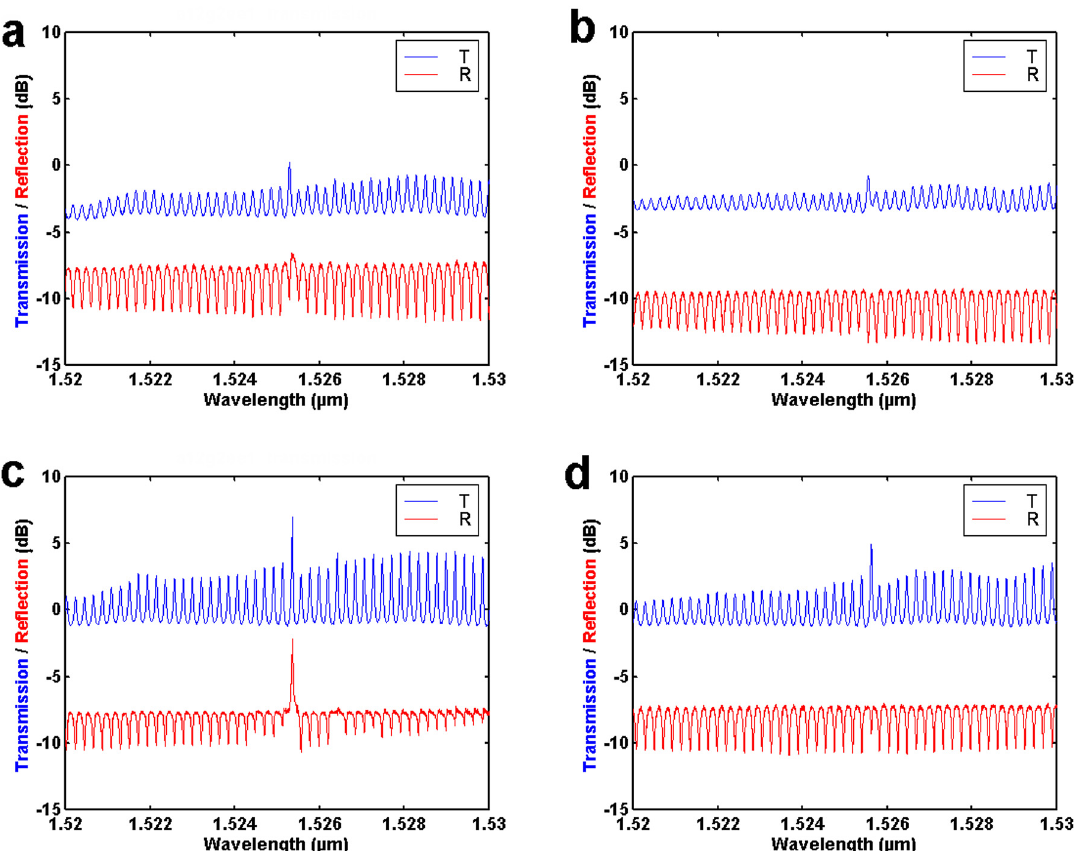
Figure 6: Example of transmission(blue) and reflection (red) spectra showing asymmetric amplification. On one direction (left-hand figures), the reflection is amplified at a Bragg wavelength, while the reflection spectrum in the opposite direction (right-hand figures) is not. a) and b) Injection current I = 50 mA; c) and d) Injection current I = 60 mA. The re fl ection spectra are offset for clarity by − 10 dB with respect to transmission one.